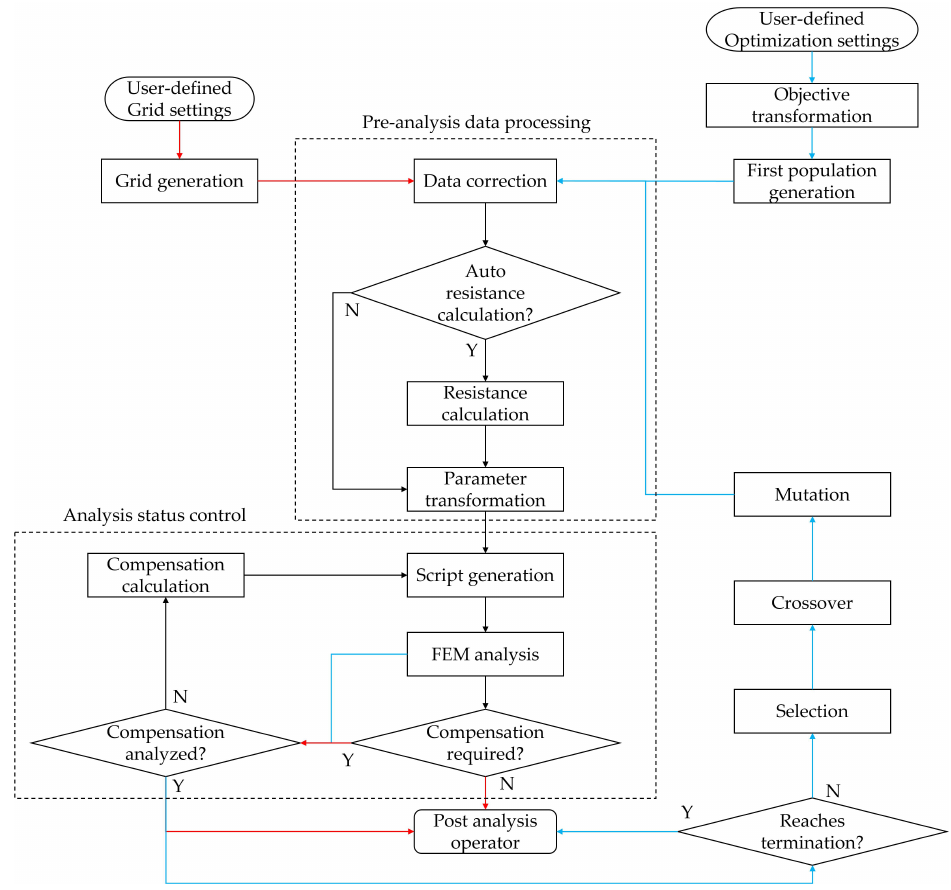
Figure 7. Flowchart of the grid and optimal approaches. The red arrows show the flow of the grid approach, the blue arrows for the optimal approaches, and the black arrows as the shared